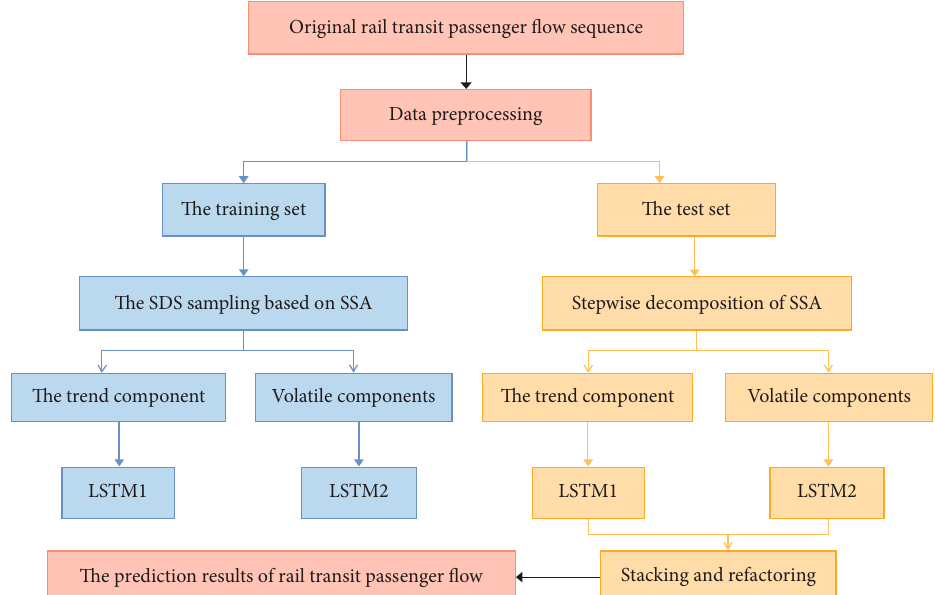
Figure 3: The process of the STPF prediction based on